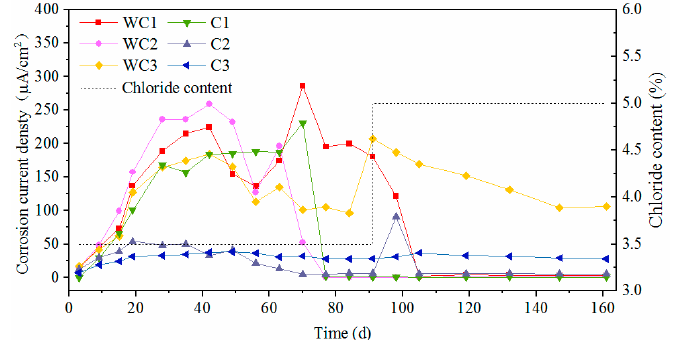
Figure 11. Corrosion current density of HRB500 carbon steel .